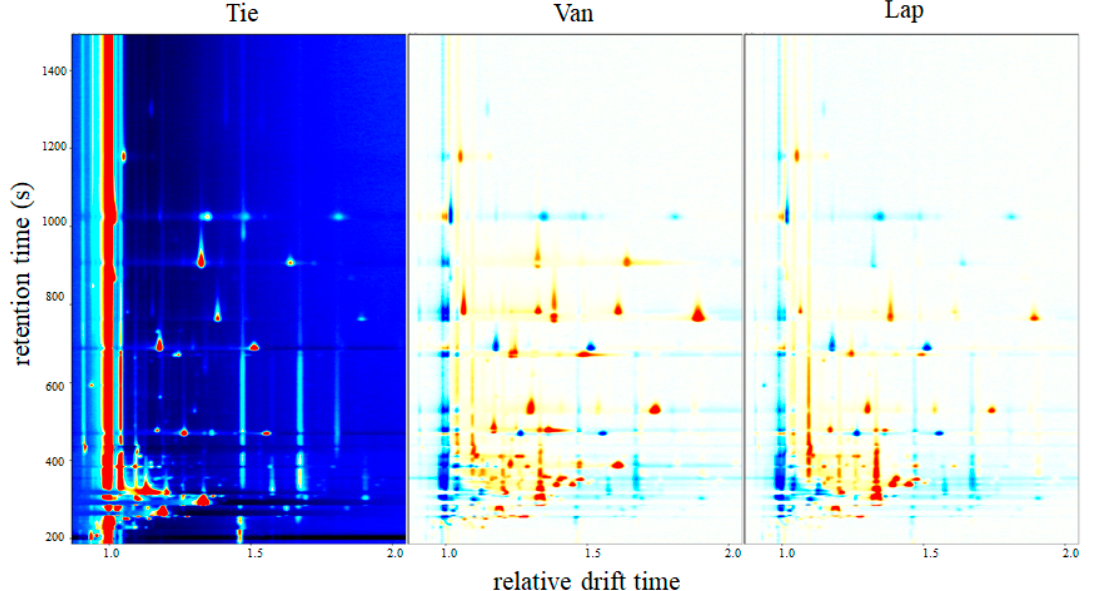
Figure 2. Differences in the two-dimensional (2D)-topographic of volatile compounds in cherry fruits from three cultivars.